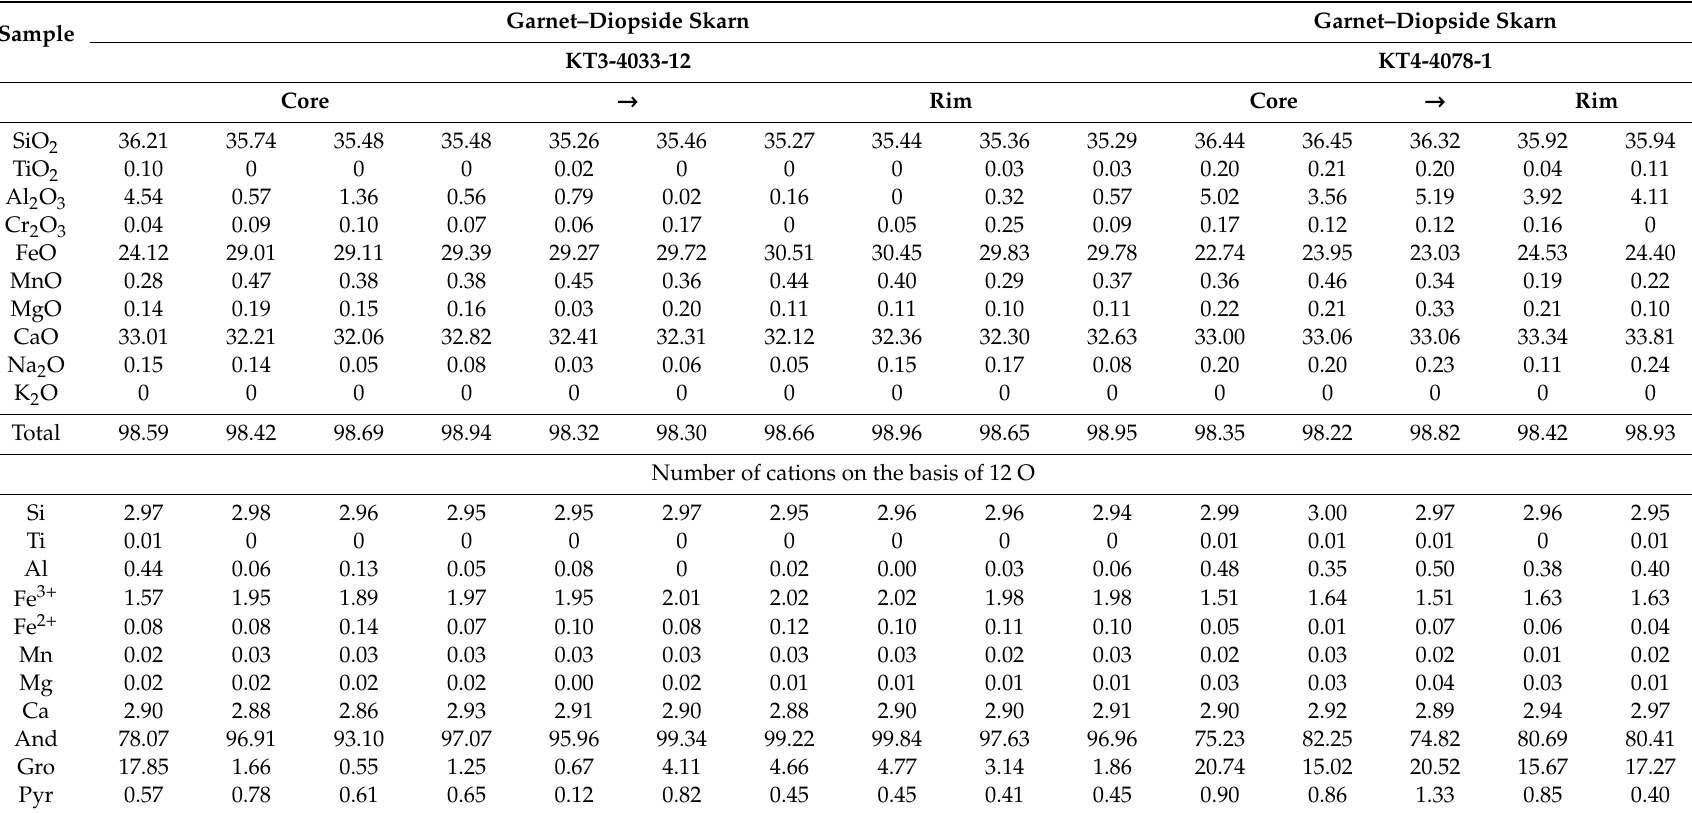
Table 1. Electron microprobe analyses of garnet from the Hongshan deposit (wt